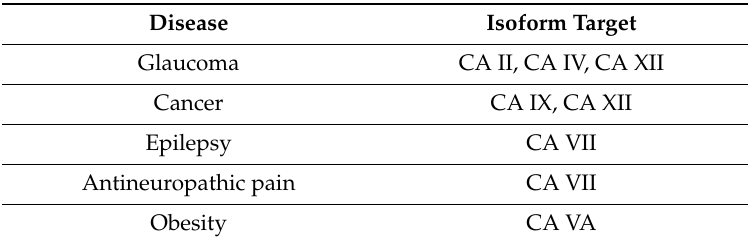
Table 1. Carbonic anhydrase (CA) isoforms and associated diseases.